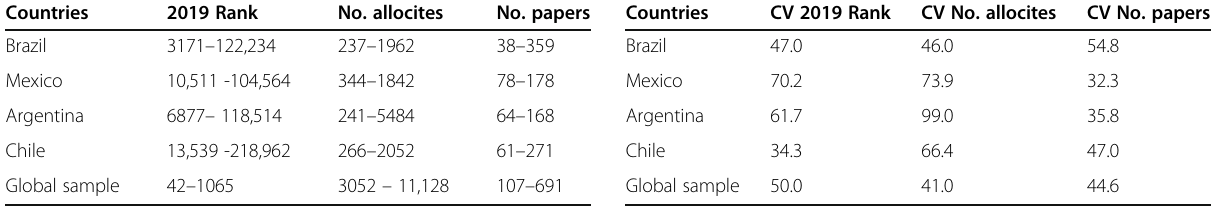
Table 5 Ranges of scientometric indicators, regarding position in the 2019 Single-year impact ranking, No. allocites, and No. papers in the Scopus database, for the most scientifically productive countries in Latin America (from Table-S7, 2019 Single-year ranking, by Ioannidis et al. [3]) Countries 2019 Rank No. allocites No. papers